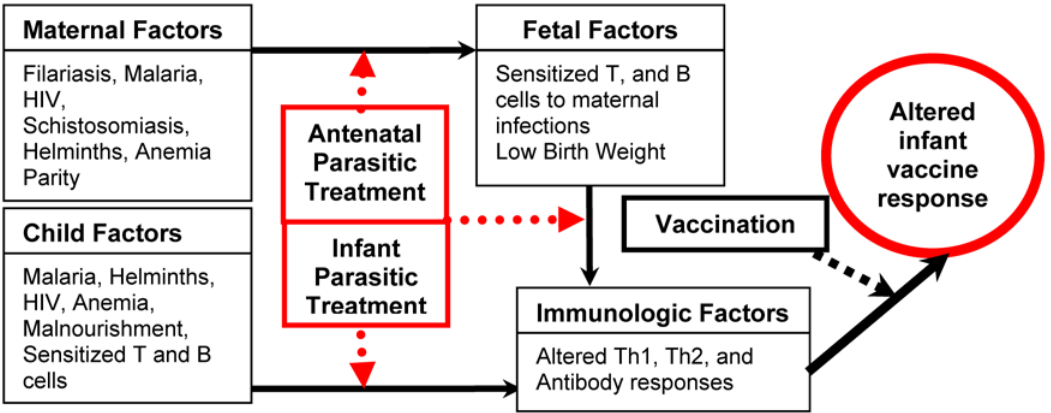
Figure 1. Theoretical mechanisms of reduced vaccine response in infants.